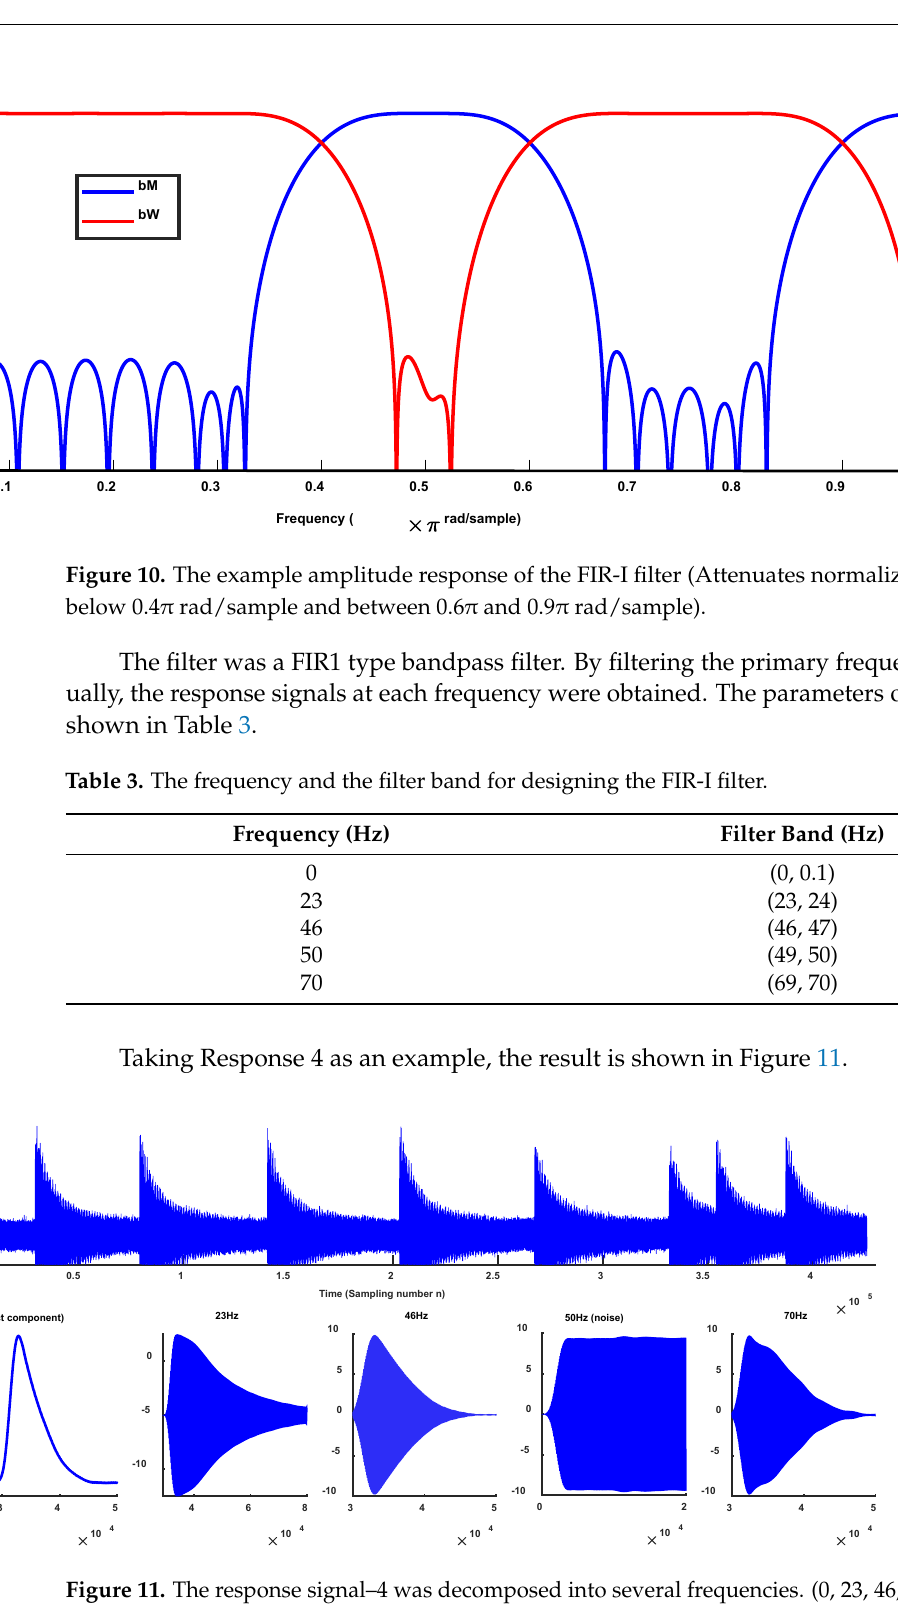
Figure 11. The response signal–4 was decomposed into several frequencies. (0, 23, 46, 50 and 70 Hz). Figure 11 shows that the 0 Hz component was the fundamental motion without oscillation. The frequency component of 50 Hz did not change with the load; thus, it was noise. In conclusion, three frequencies of 23, 46 and 70 Hz were selected as identification response signals as shown in Figure 12.